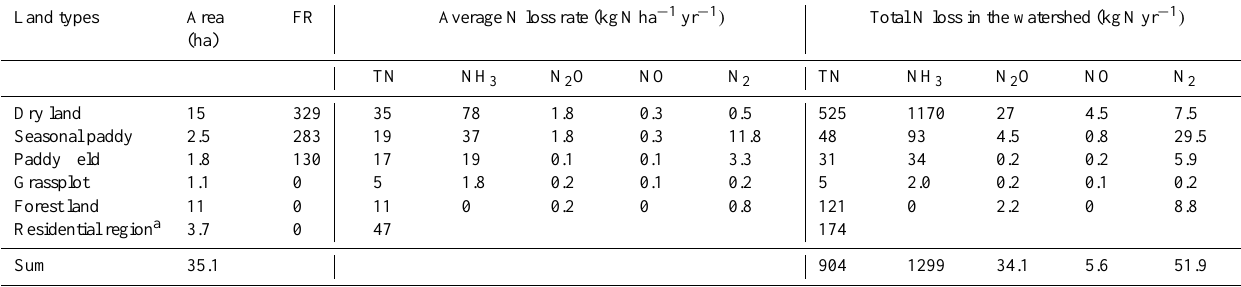
Table 2. The modeled average and total N loss rates for different land use types in 2008. Land